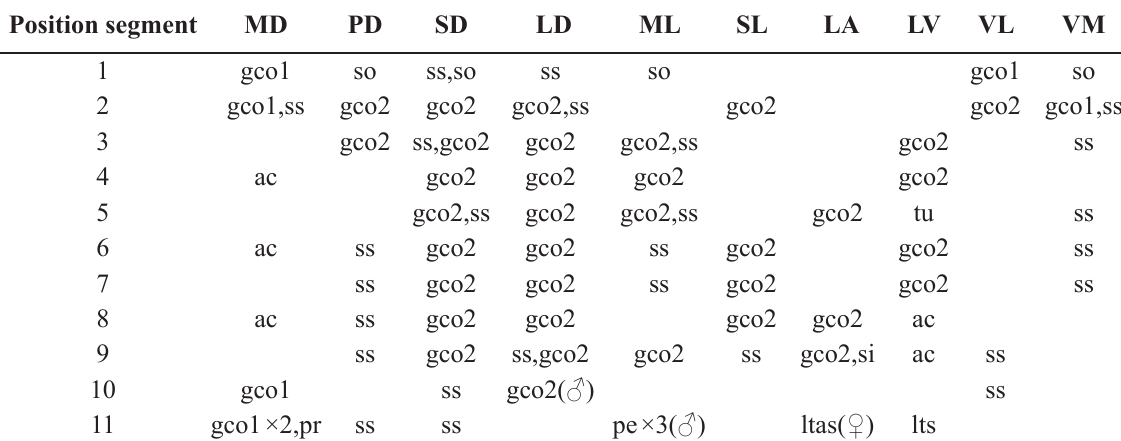
Table 19. Summary of nature and location of sensory spots, glandular cell outlets, tubes and spines arranged by series in Echinoderes aragorni sp.